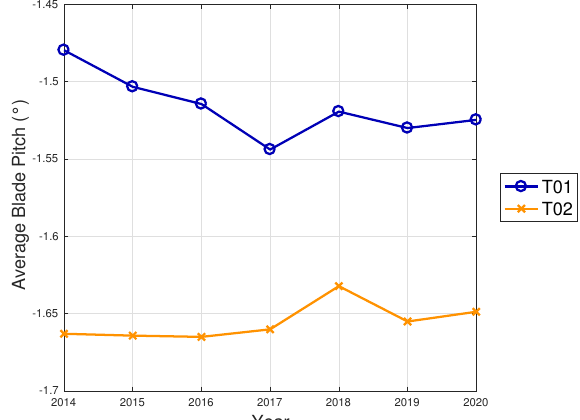
Figure 17. Average blade pitch in region for T01 and T02.